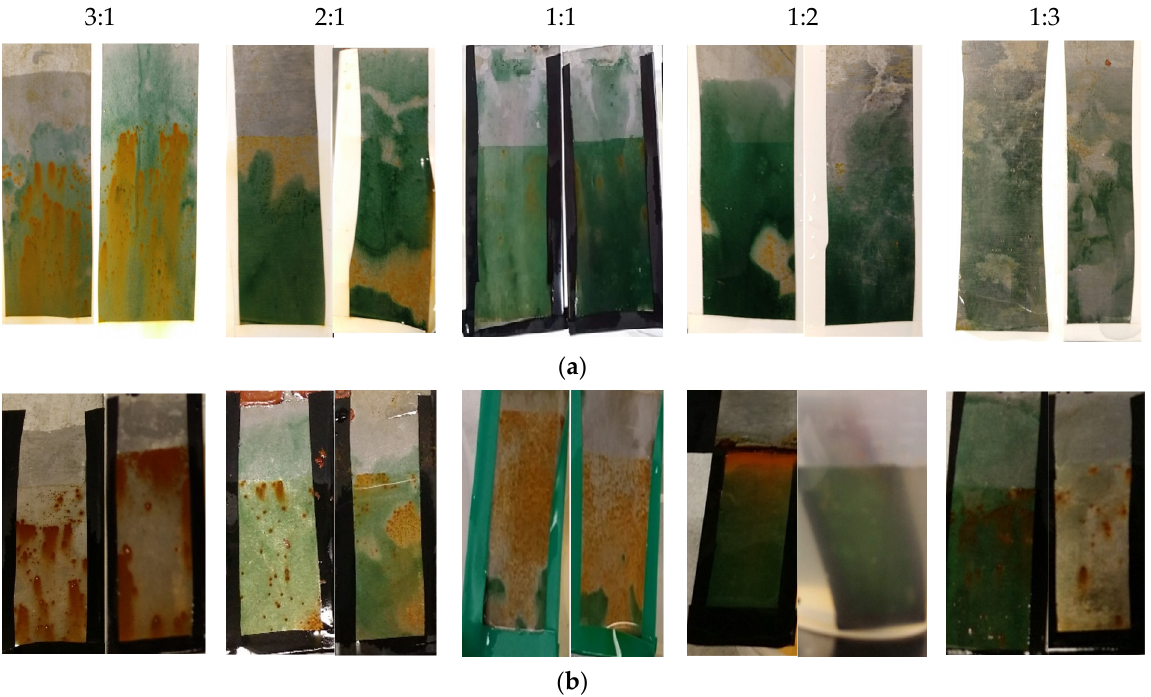
Figure 8. Corrosion prevention performance associated with development of rust on coupons coated with ( a ) TGST and ( b ) LA(TGST) formulations with varying TG:ST stoichiometry between 3:1 to 1:3 after exposure for 25 h in Dilute Harrison’s Solution (DHS).